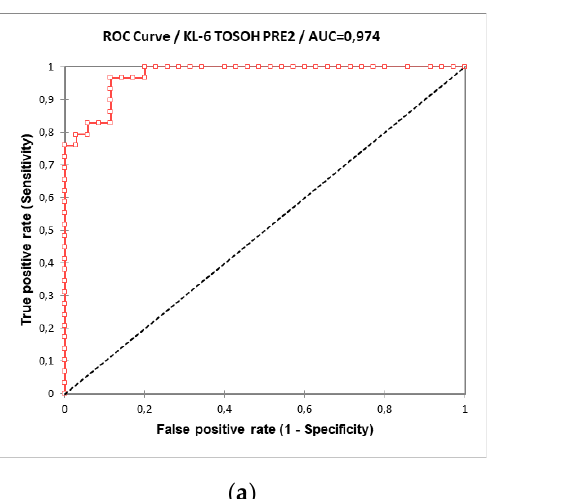
398 U/mL with 89% specificity and 97% sensitivity.